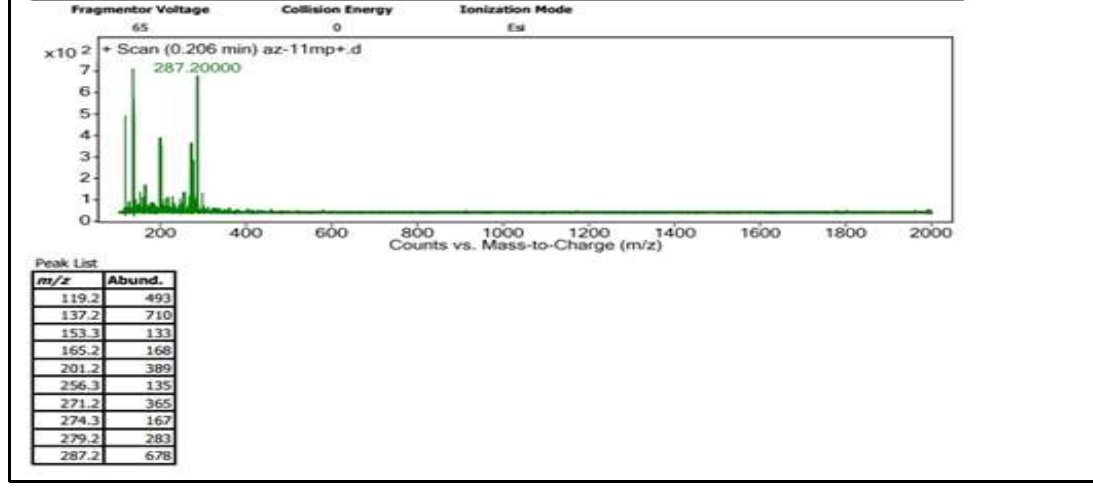
Figure 12:LC/MS for isolated compound A6(1) LC/MS of isolated compound (A1): the result show in Figure13.